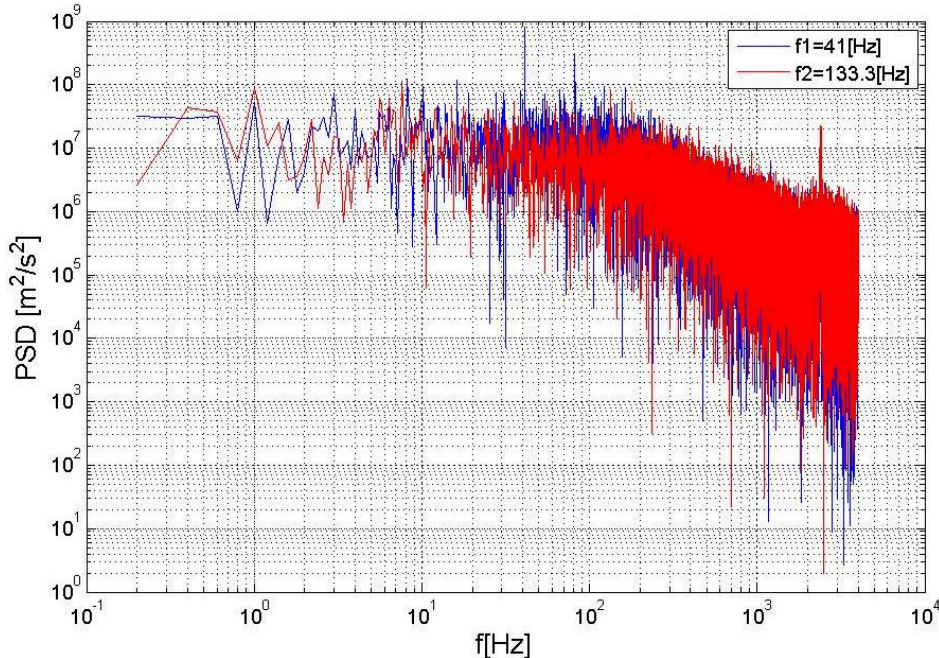
Figure 16. Power spectra at Re = 200,000 and α = 16 ◦ .